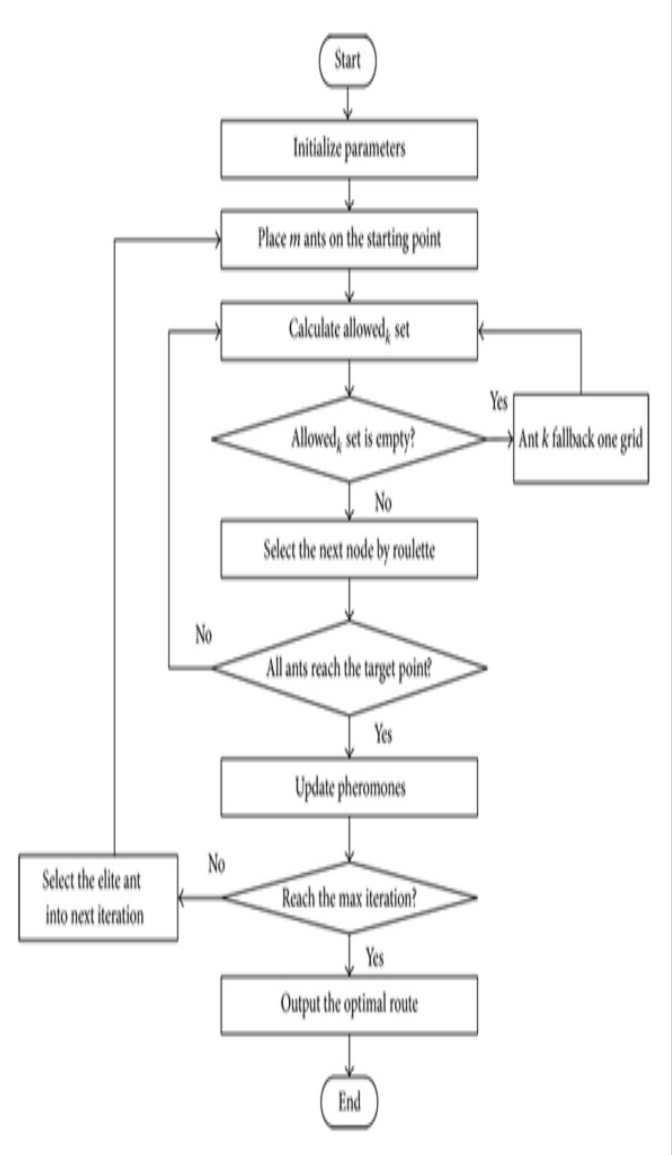
Figure 1. Flowchart of ANT SYSTEM